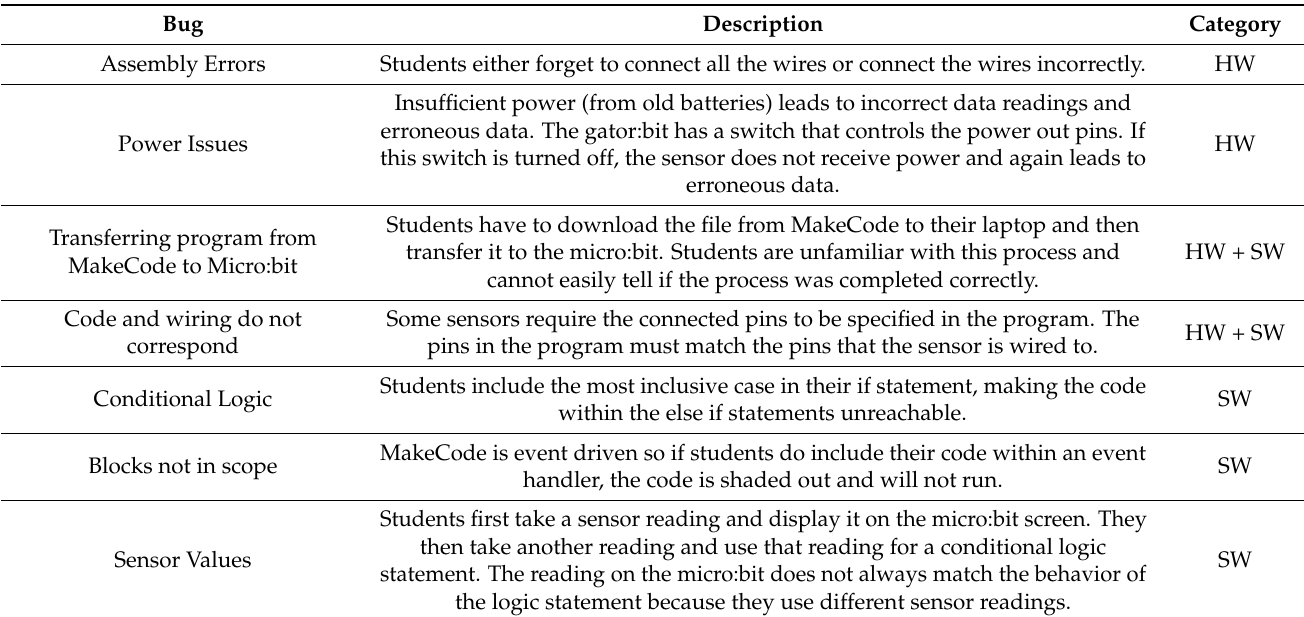
Table 2. Common errors in hardware, software, and combinations of hardware and software. Bug Assembly